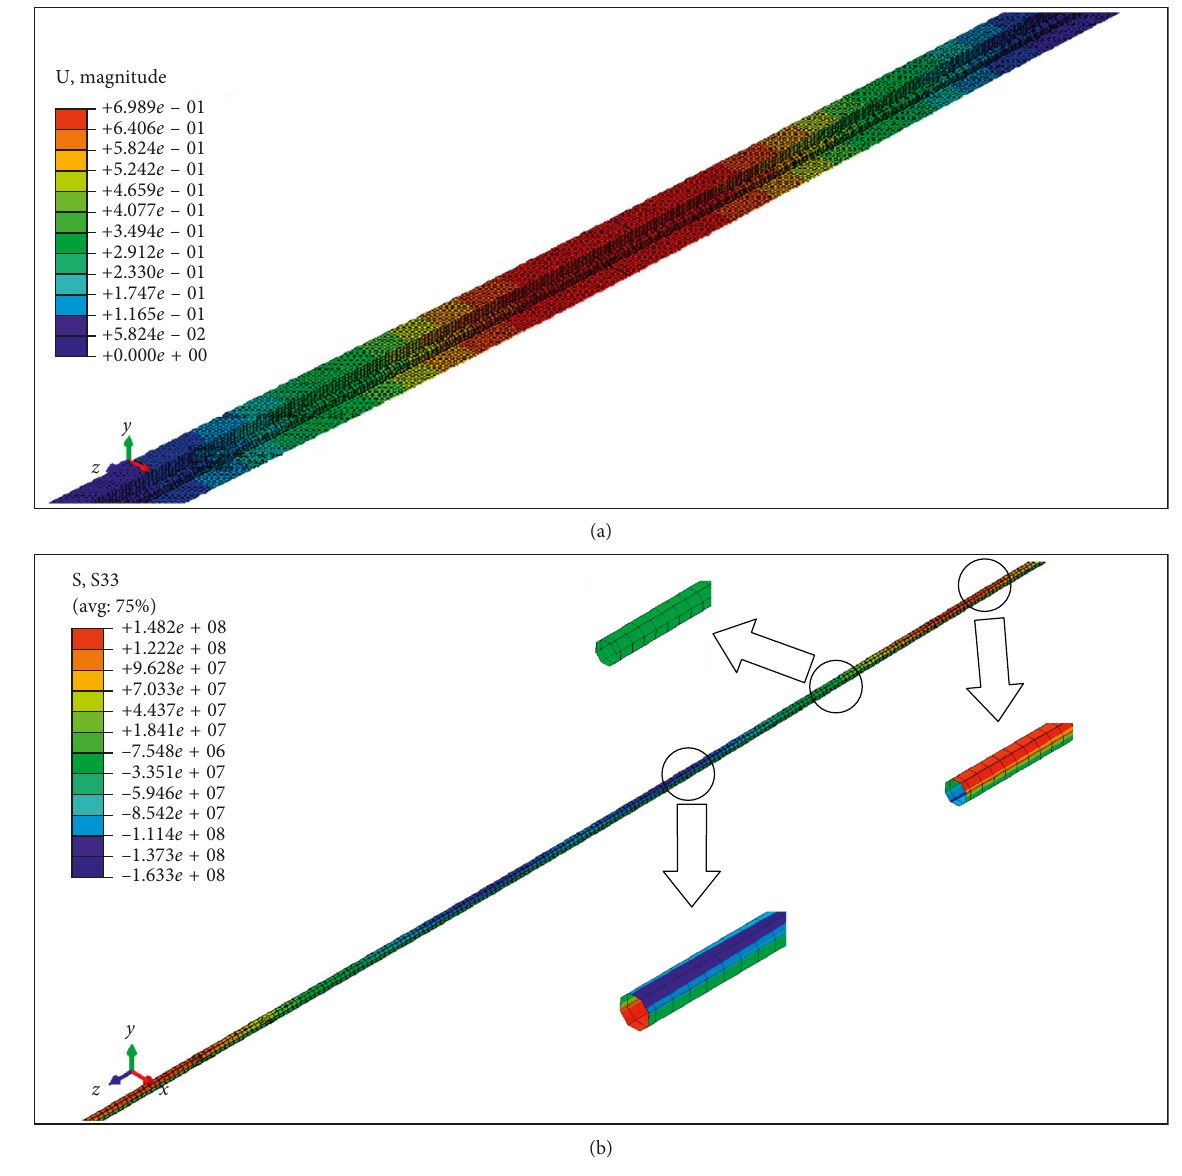
F IGURE 15: Deformations and additional stresses along the buried pipeline: (a) distribution of the deformations about buried pipeline and its surrounding soil and (b) additional stress distribution along the buried